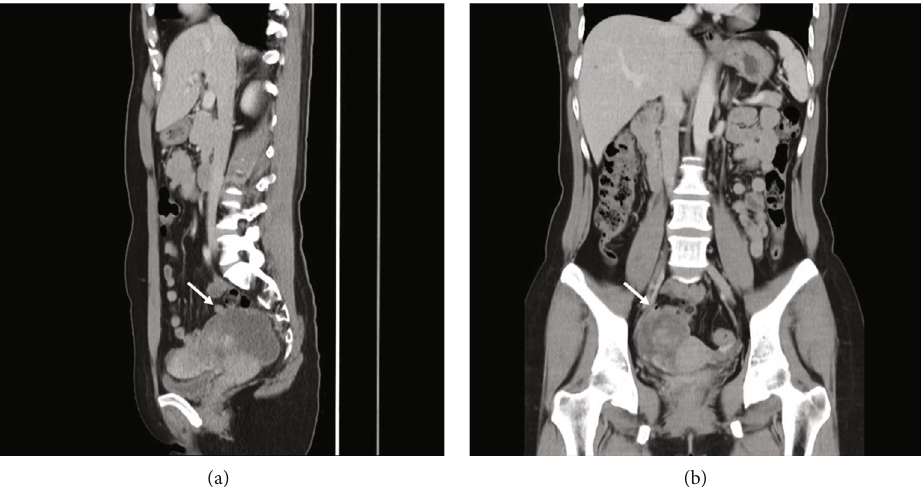
Figure 2: Abdominal computed tomography of the tumor. The tumor was with solid and cystic components in the right pelvic cavity. (a) Sagittal view (arrow), (b) coronal view